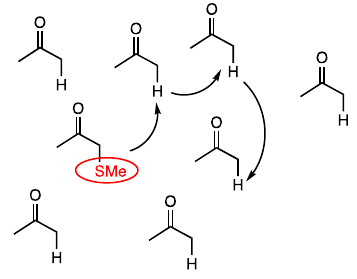
Figure 6. Rhodium-catalyzed hopping of methylthio groups among ketones at α -positions.